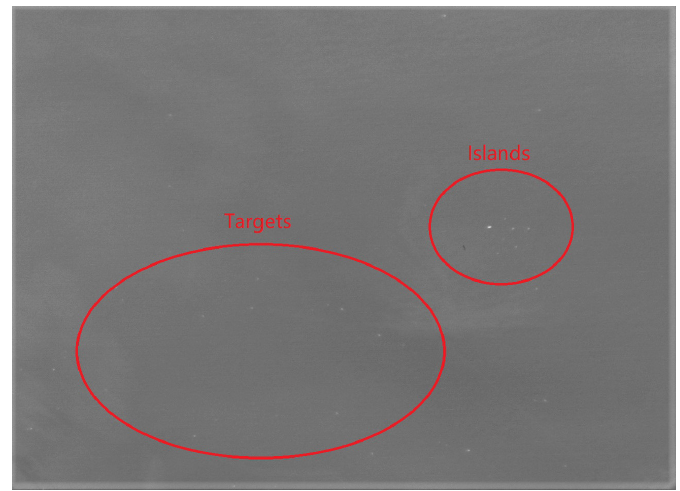
Figure 2. Similar islands and targets.